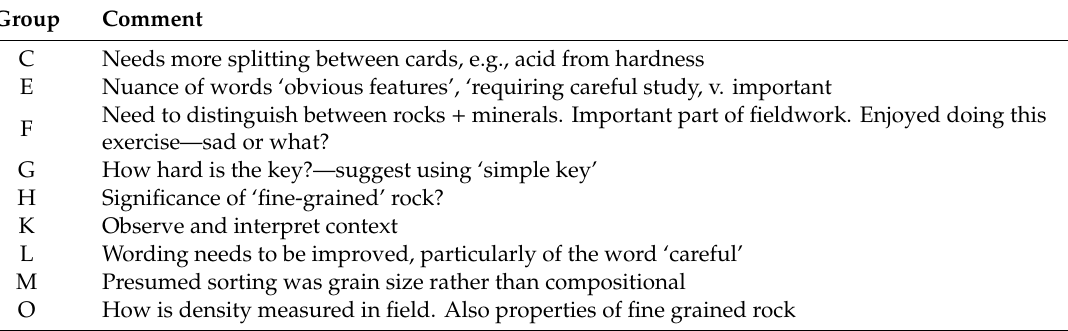
Table A3. Identify rocks / minerals correctly.